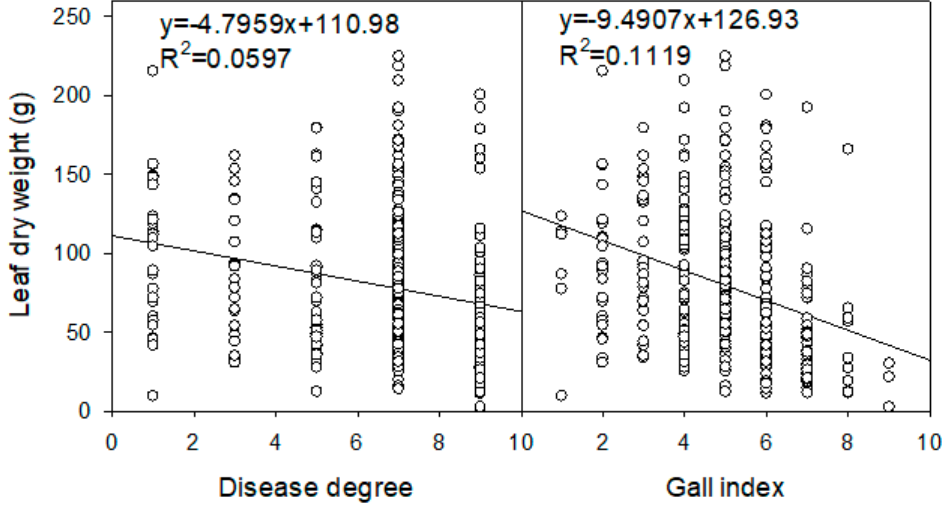
Figure 1. Regression between the leaf dry weight and the traditional indicators of disease degree and gall index. n = 360.